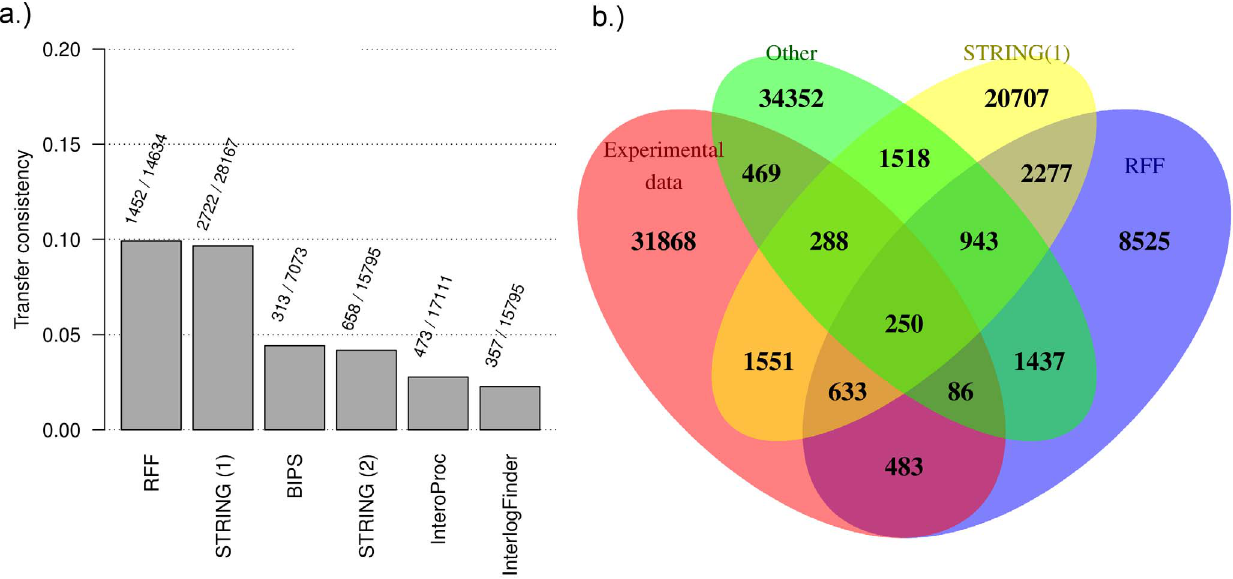
Figure 5. Method comparison. Comparison of interaction transfer sets from various methods for H. sapiens with known H. sapiens interactions from iRefIndex. We compare interaction sets from STRING [62], InteroPORC [21], InterologFinder [24], BIPS:BIANA [25] and our Random-Forest-Filter ( RFF ). From the STRING database only interactions with interaction transfer information from other species and a combined score over 0.7 are included ( STRING(1) ). The combined score uses information from all information sources including knowledge on experimental interactions for the respective species (direct evidence). Therefore, an additional interaction set is created where the combined STRING score is recomputed excluding the scores from the direct evidence of databases, experiments and text-mining ( STRING(2) ). In general, the intersections between the different sets and the known interactions are small. a.) With the RFF and with STRING(1) 10% of the predicted interactions can be found in the experimental data. The modified STRING(2) interaction set is 43% smaller and only 4% of the predicted interactions are consistent with the experimental data showing a clear performance advantage of the RFF for species with no experimentally determined interactions. b.) We compare the interaction sets of RFF , STRING(1) , a combined set of unique interactions from InteroPORC , InterologFinder and BIPS:BIANA and a set of known H. sapiens interactions. With the RFF 42% of predicted interactions can also be found in one of the other sets.